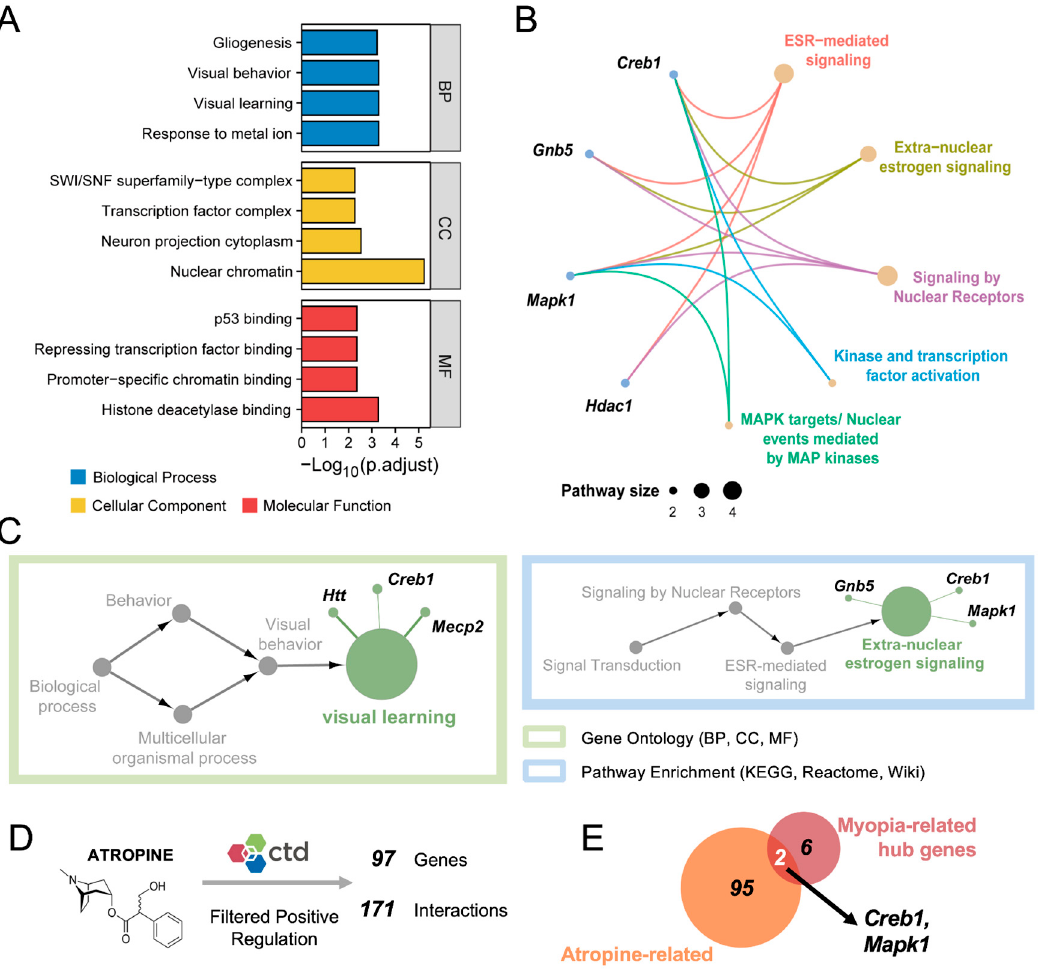
Figure 3. GO annotation and pathway enrichment analysis based on the top hub genes. ( A ) Selected enriched GO terms of the top eight hub genes. The colored bars show the top four ranked GO terms in BP, CC and MF, respectively; ( B ) Pathway enrichment analysis of the eight hub genes. The blue nodes represent genes, and the yellow nodes represent pathway names. The larger the nodes’ size, the smaller the value of P . The branches indicate the relationship between genes and pathways. Branches of the same color come from the same pathway and point to their different follower genes; ( C ) GO terms and enriched pathways are summarized based on semantic similarity measures; ( D ) Atropine-targeted genes from the CTD database: 97 genes could be downregulated by atropine treatment; ( E ) Venn diagram shows that two out of the eight hub genes are negatively related to atropine treatment. BP: Biological Process, MF: Molecular Function, CC: Cellular Component, CTD: Comparative Toxicogenomics